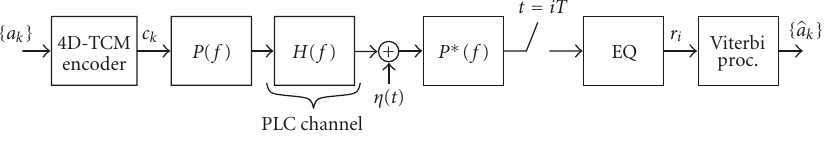
Figure 2: Simplified system model with a suboptimal implementation of the front-end